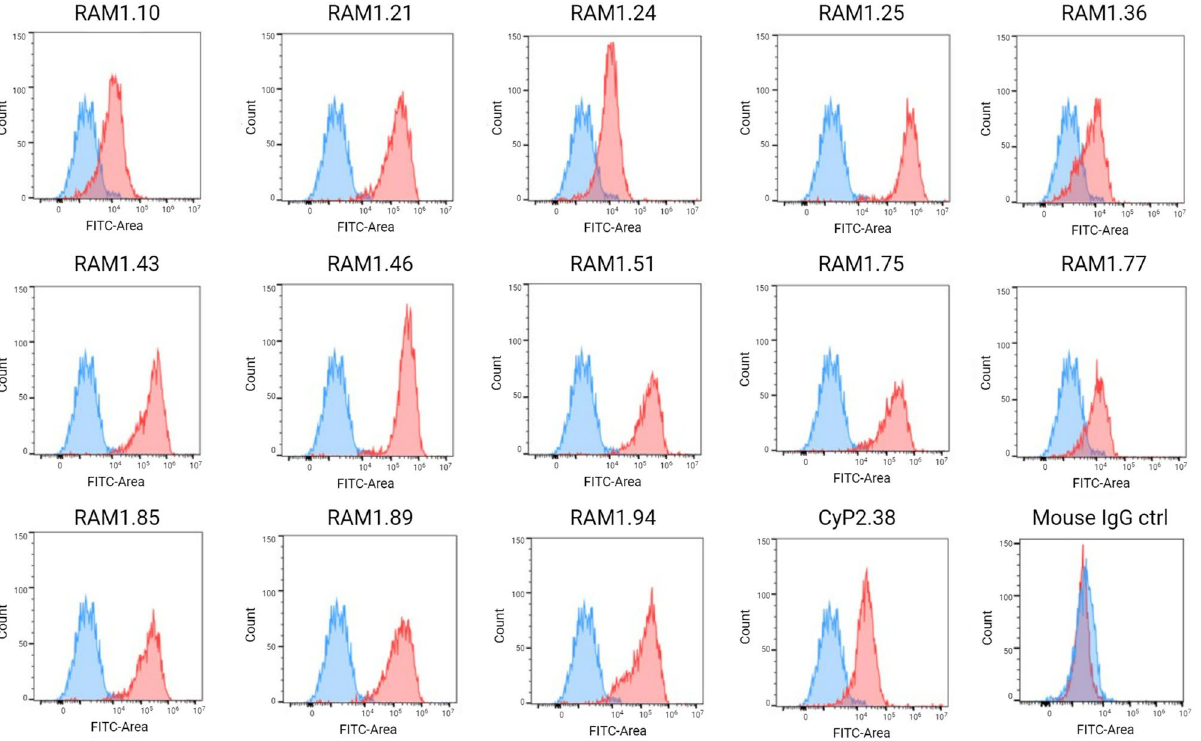
Figure 2. Flow cytometry analysis of anti-PfRAMA mAbs binding to P. falciparum merozoites. The histograms (red curves) show each of the anti-PfRAMA mAbs binding to 3D7 merozoites after detecting the mAbs with FITC conjugated anti-mouse IgG. The blue curve represent the negative control generated by adding the detection antibody only. The anti-PfCyRPA mAb (CyP2.38) was included as a positive control and non-malarial specific mouse IgG was included as a negative control. The histograms were generated by gating on size/ granularity, single cells and positive nuclei DAPI